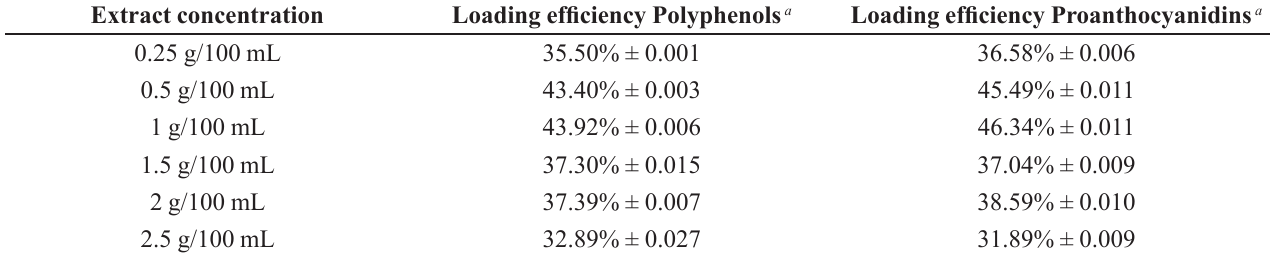
TABLE I - Effect of extract concentration on total extractable polyphenols and proanthocyanidins loading efficiency Extract concentration